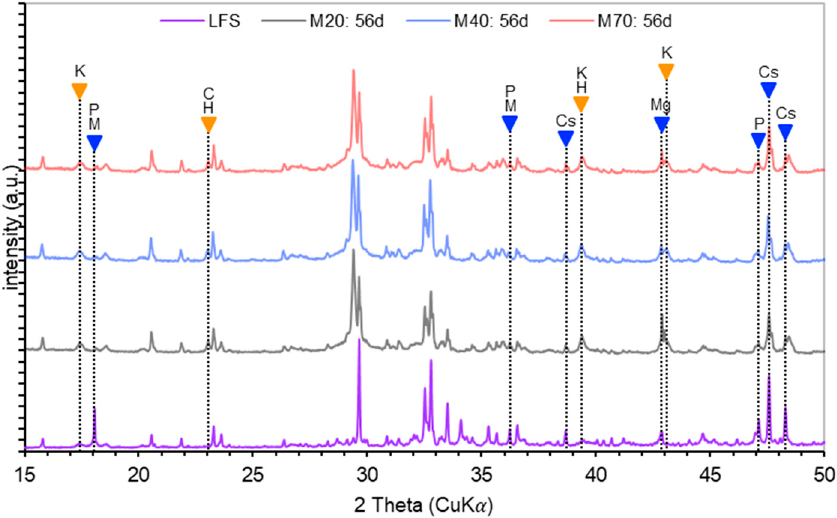
Figure 6. XRD patterns of raw slag and alkali-activated slag at different temperatures and 56 days of curing. K: katoite, P: portlandite, M: mayenite, C: calcite, H: hydrocalcite, Cs: calcium silicate, Mg: